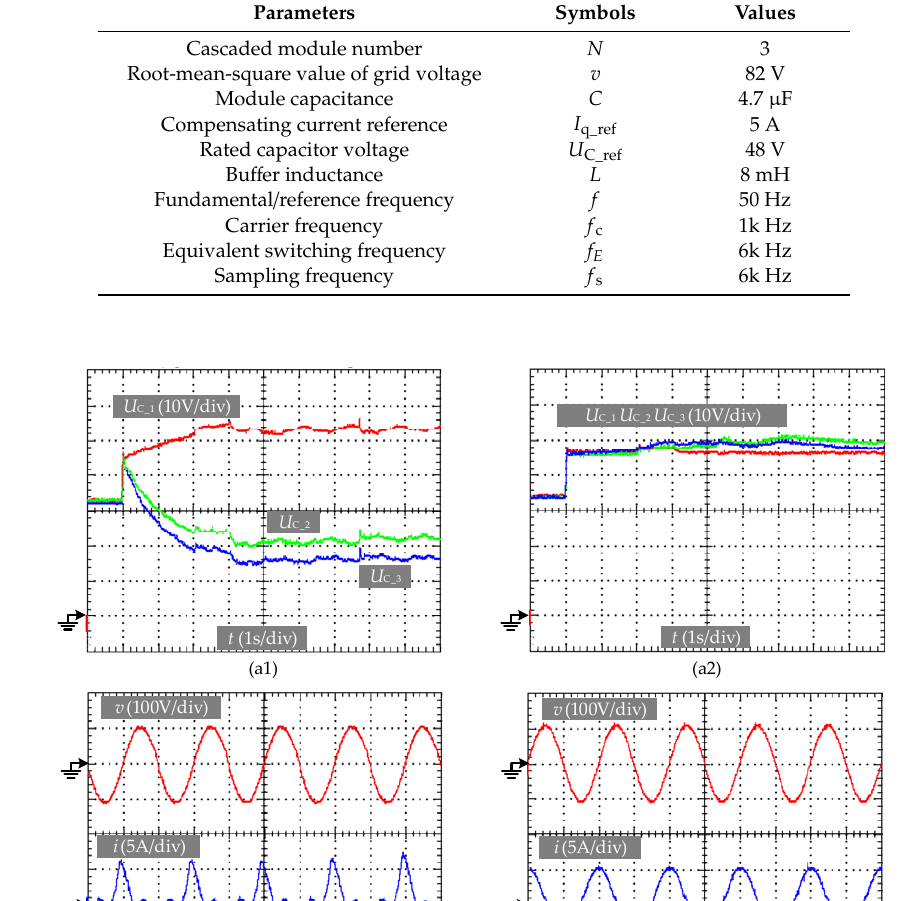
Table 2. System parameters in the experiment.